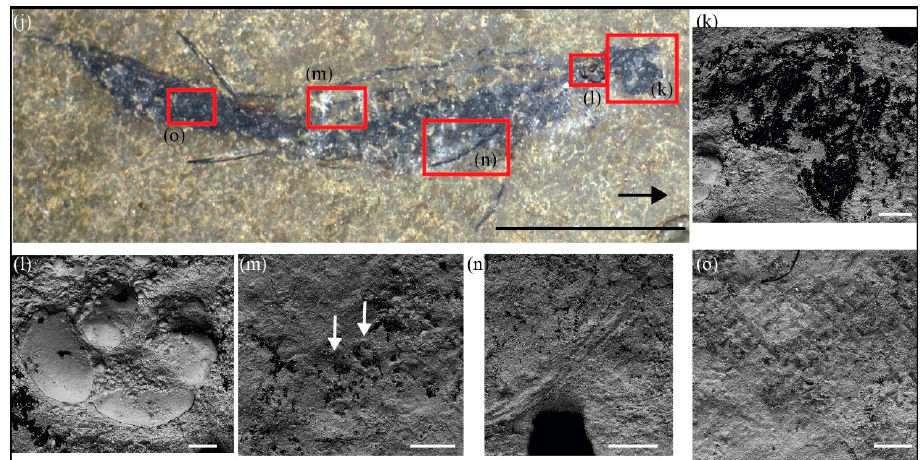
Figure 1. Triazeugacanthus affinis anatomical structures for energy dispersive X-ray spectrometry (EDX) analyses. ( a ) Larval specimen the Musée d’Histoire naturelle de Miguasha (MHNM) 03-440 #1 and scanning electron microscopy (SEM) close-ups of the ( c ) head region. ( b ) Larval specimen MHNM 01-440 #2 and SEM close-up of the ( d ) notochordal elements, ( e ) scapulocoracoid and pectoral fin spine, and ( f ) head region. ( g ) Juvenile specimen MHNM 03-398, red line shows the position of the histological section ( h ) of the anal spine and ( i ) the two lateral coverings of body scales in cross-sections. ( j ) Juvenile specimen MHNM 03-1252 and SEM close-ups of the ( k ) eye lenses, ( l ) otoliths, ( m ) notochordal elements (white arrows), ( n ) pectoral fin spine, ( o ) scales. Red squares show SEM close-up areas. Arrows point forward. Scale bars = 1 mm in (a) and (b); 600 μ m in (c); 500 μ m in (d); 800 μ m in (e) and (f); 5 mm in (g) and (j); 10 μ m in (h); 20 μ m in (i); 200 μ m in (k), (m), and (o); 100 μ m in (l); and 500 μ m in (n).